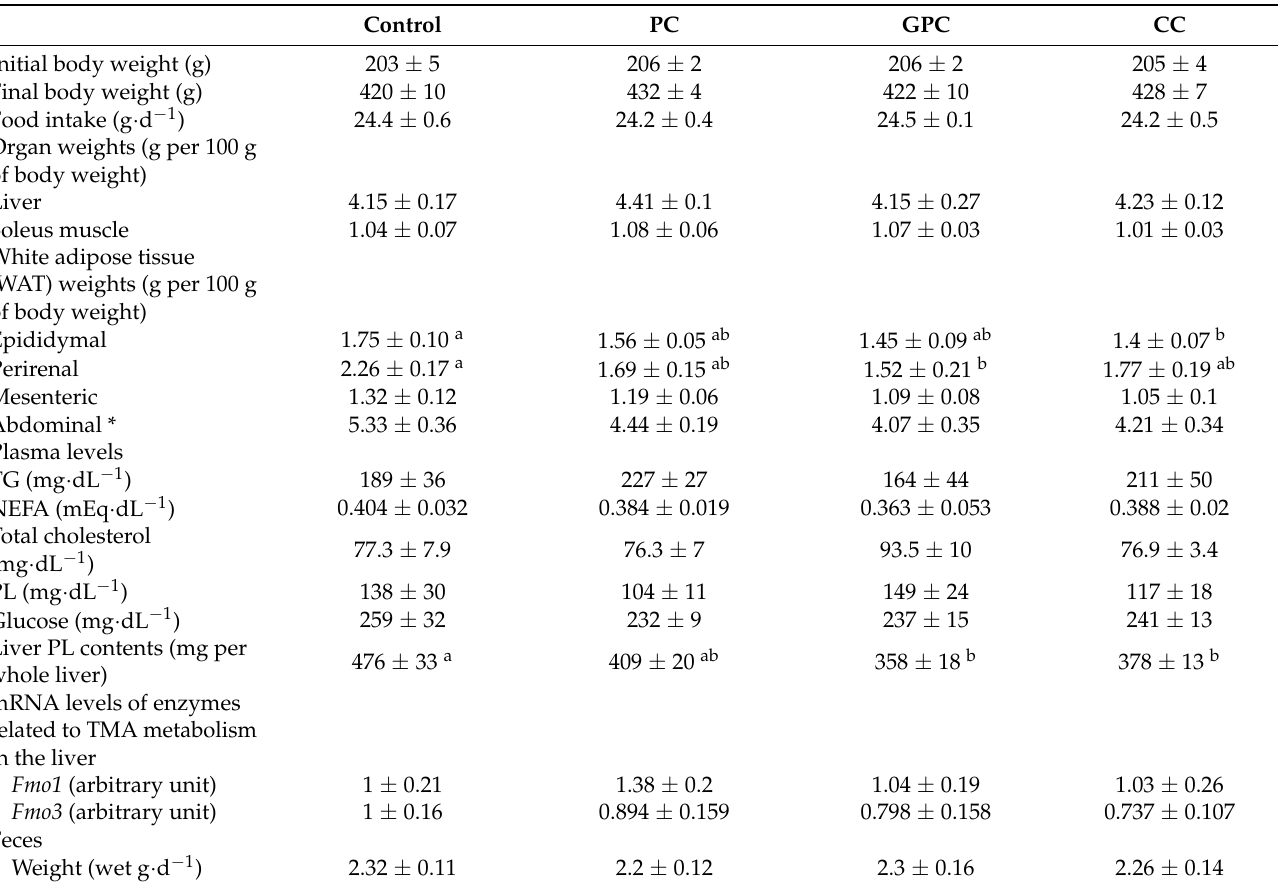
Table 1. Effects of diets containing choline compounds on morphometric and metabolic parameters in